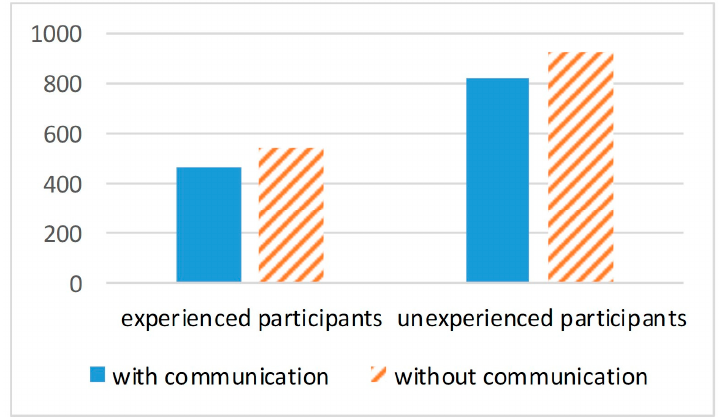
Figure 19. Means of experienced participants and unexperienced participants under various experimental conditions (horizontal axis: single-man, two-man, three-man; vertical axis unit: seconds).